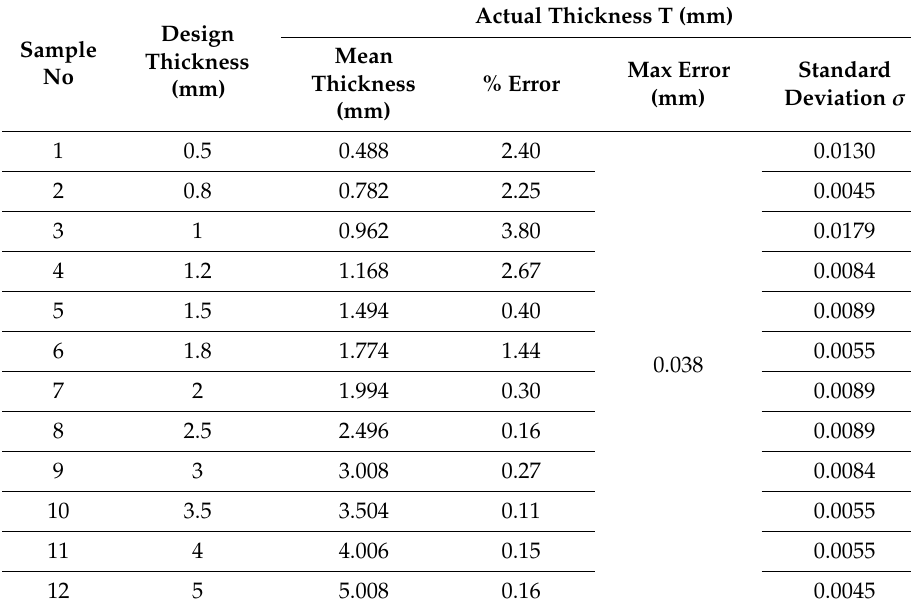
Table 3. Measurement results of sample thickness.